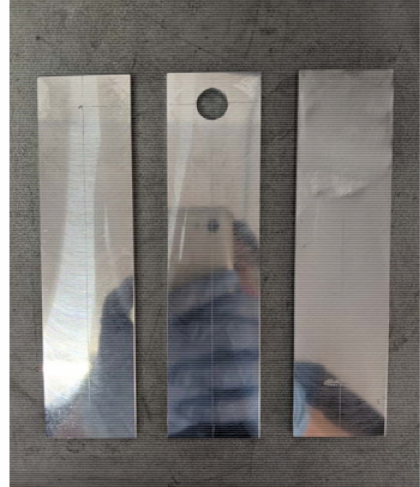
Figure 5. The left-most plate shows the substrate before drilling the hole. The substrate in the middle shows the location of the 12 mm diameter hole. The plate on the far right shows the hole after being filled up with cold-sprayed material and manually ground until flat on both sides.